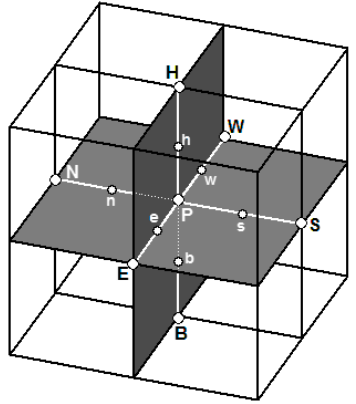
Figure 2. Schematic view of the mesh.